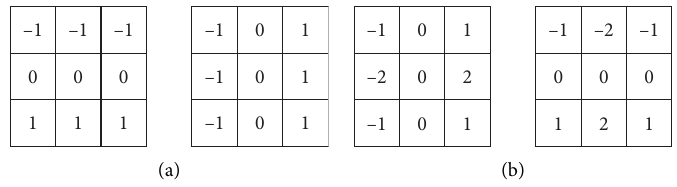
Figure 3: Prewitt and Sobel operator templates. (a) Prewitt operator. (b) Sobel